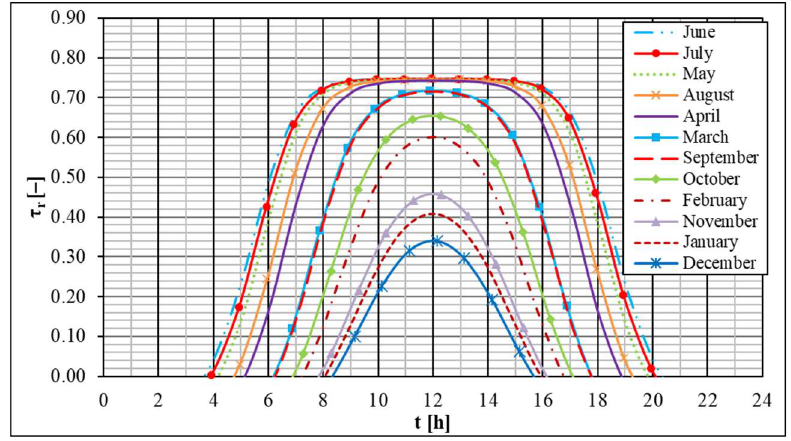
Figure 5. Transmissivity after accounting for multiple reflections of solar rays from two walls of 236 polycarbonate (Z = 2) as a function of time for characteristic days of months.